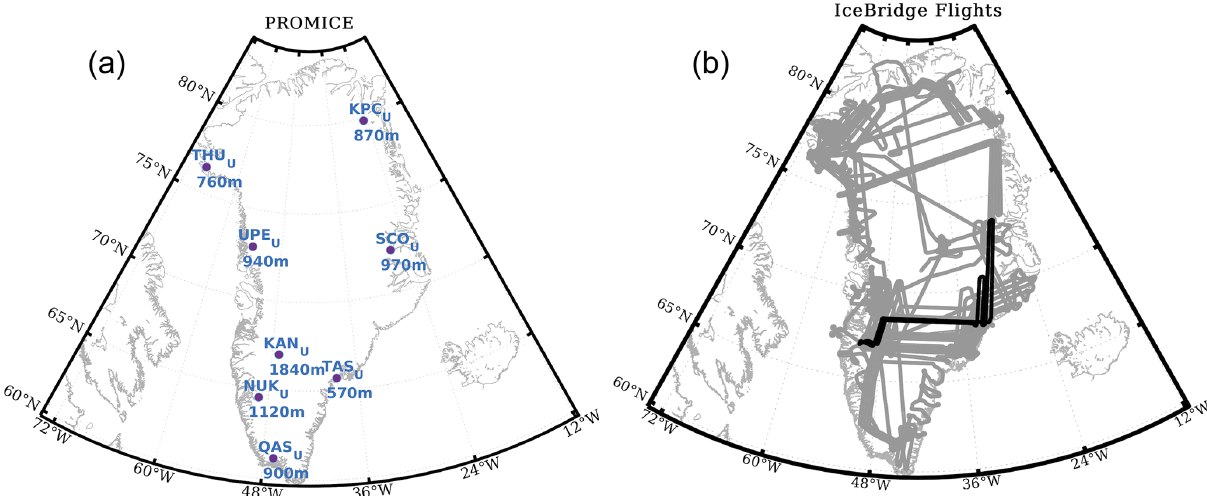
Figure 1. (a) Locations of the used PROMICE stations along the Greenland Ice Sheet and their elevation. (b) All IceBridge flights used for validation (grey lines) and the one used in Figs. 8 and 13